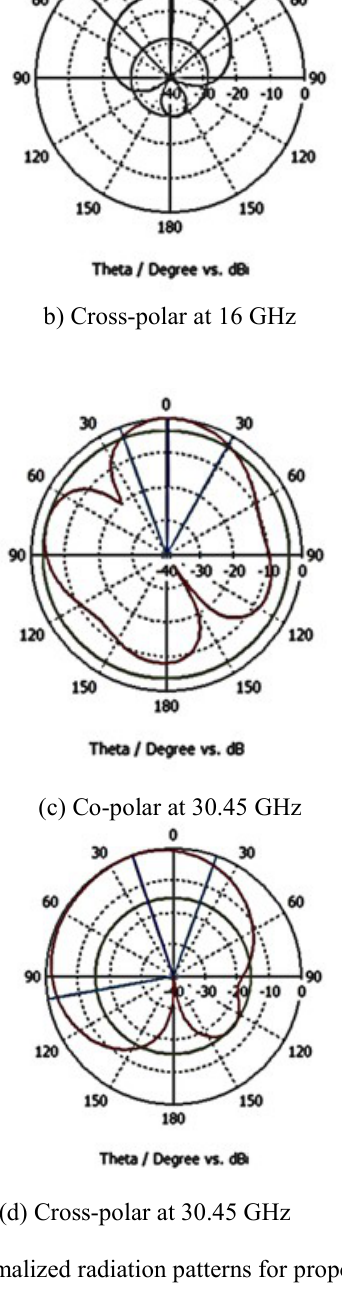
Fig. 8. Normalized radiation patterns for proposed